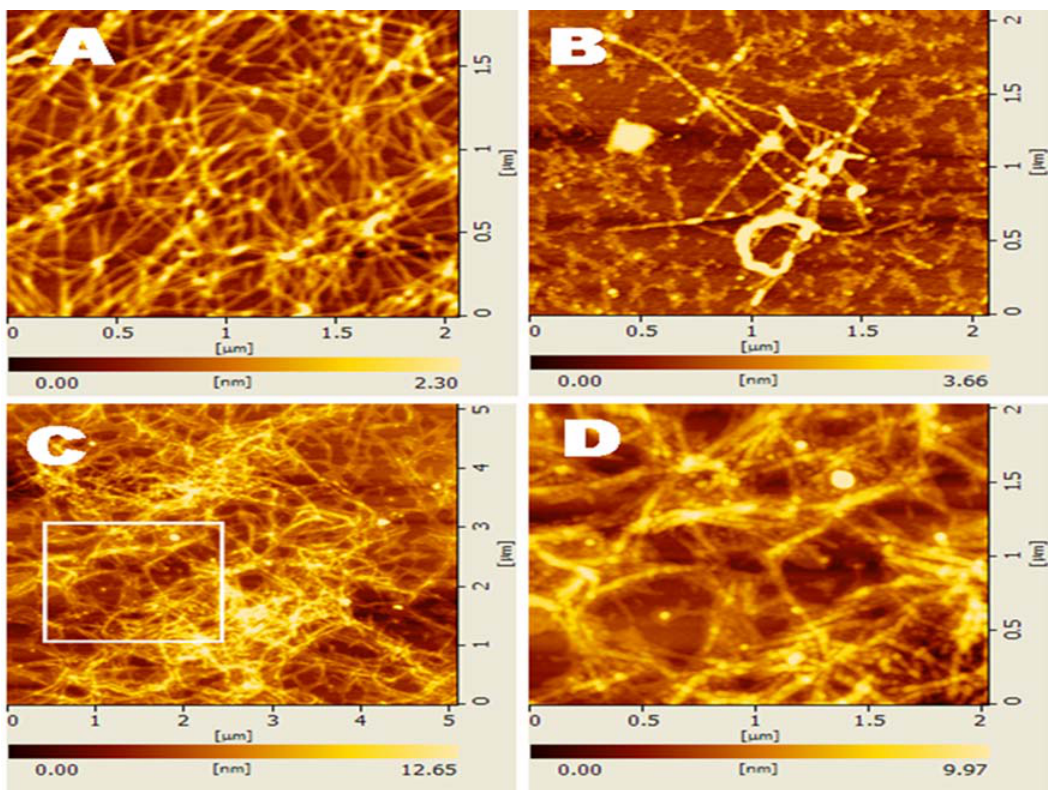
Figure 9. The AFM images of d-EAK16 (1 mg/ml, 0.1%) under repeated cycles of thermal treatment. A) d-EAK16 solution was incubated at 25 u C for 4 hours and then PBS was added to self-assembling overnight, B) d-EAK16 solution was incubated at 100 u C for 4 hours and PBS was added to self-assembling overnight, C) d-EAK16 solution was incubated at 100 u C for 4 hours and PBS was added to allow self-assembly for 2 nights, D) higher magnification of the image inside the white box C).